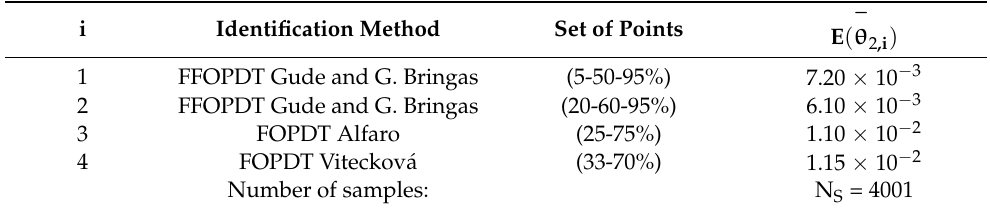
Table 11. Model performance indexes obtained for the considered identification method for FFOPDT and FOPDT models.